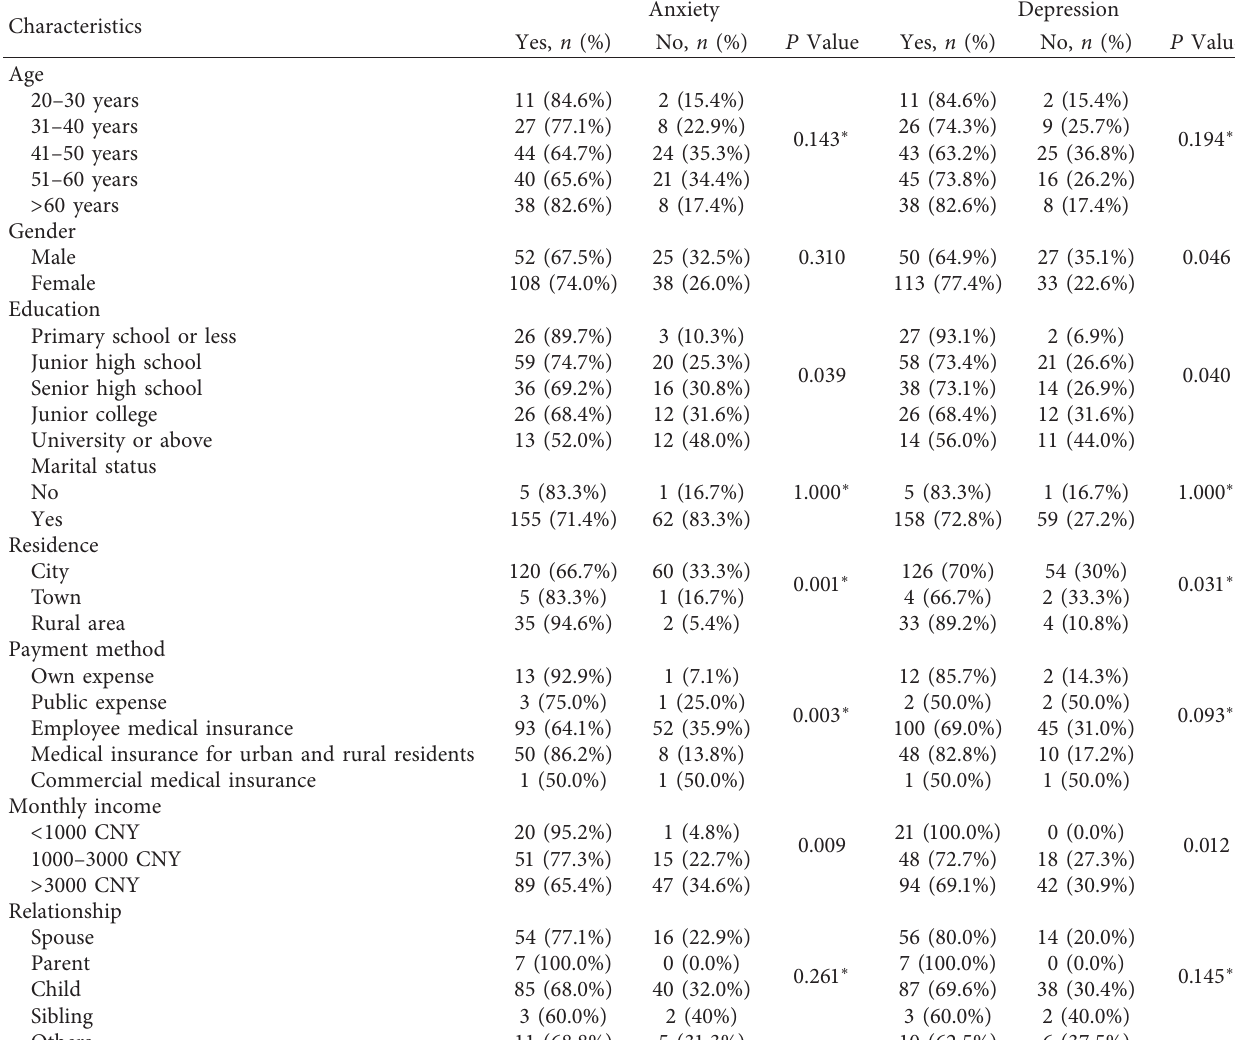
Table 3: Univariate analysis of ICU patients’ family members’ anxiety and